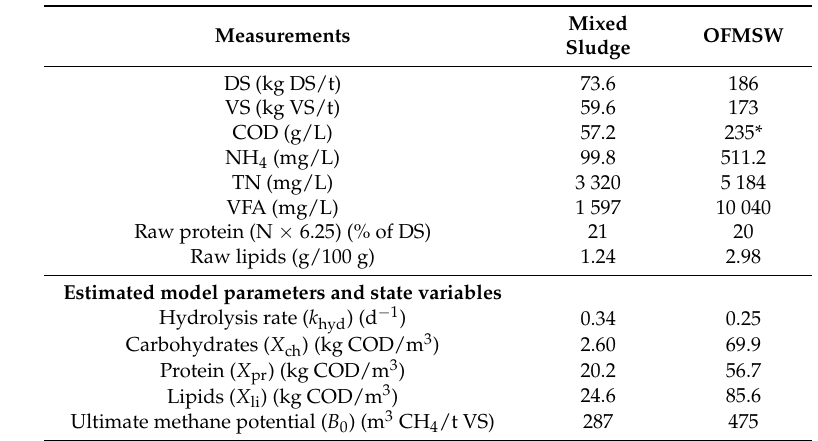
Table 1. Substrate characteristics. Selected measured values, estimated parameters and model state